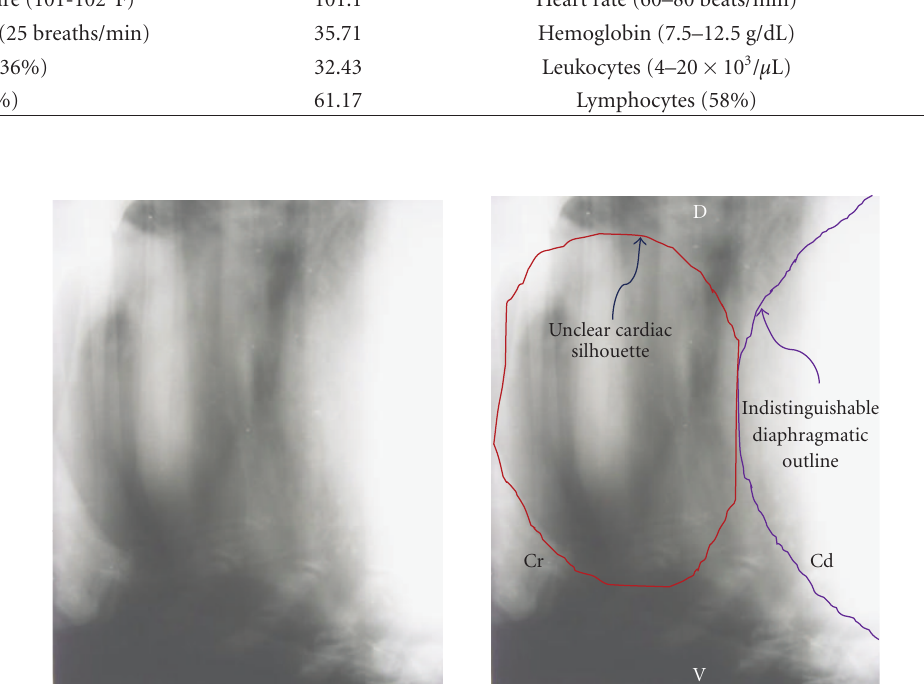
Figure 3: Right lateral thoracic radiograph of a pericarditis a ff ected cow depicting indistinguishable cardiac silhouette and diaphragmatic outline. Cr: cranial; Cd: caudal; D: dorsal; V: